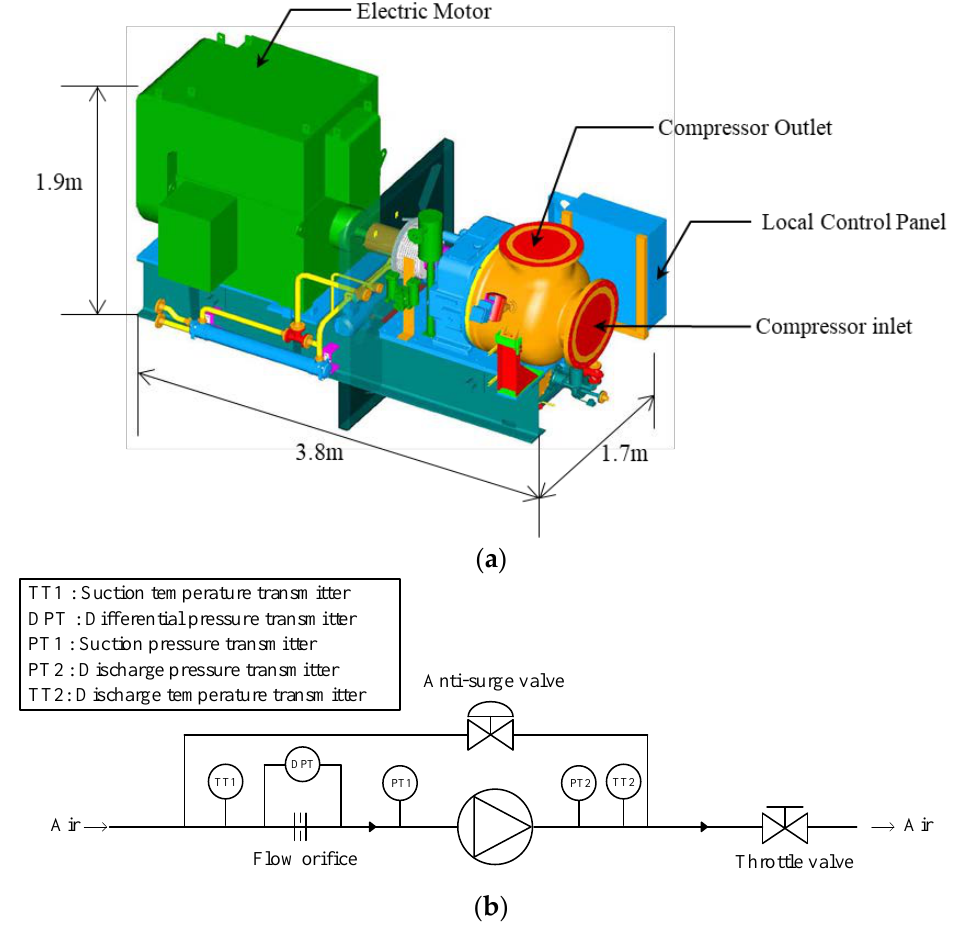
Figure 2. System configuration: ( a ) 3D drawing and ( b ) schematic diagram.